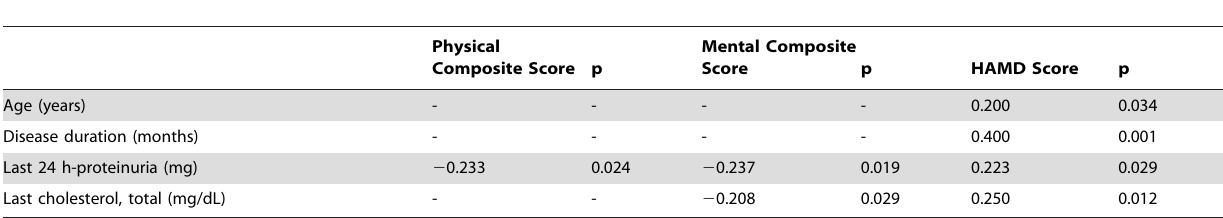
Table 4. Significant correlations ( r s ) between PCS, MCS and HAMD score with clinical and laboratory data.